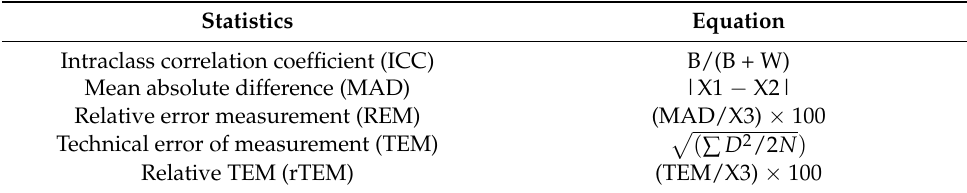
Table 4. Summary of reliability estimates evaluated. Statistics Equation Intraclass correlation coefficient